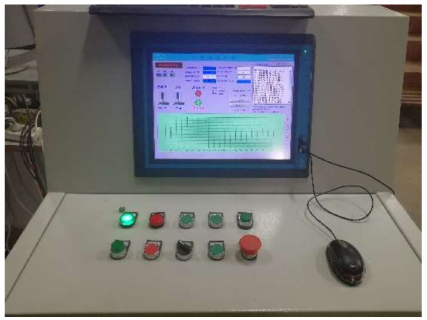
Figure 14. Flow control system.